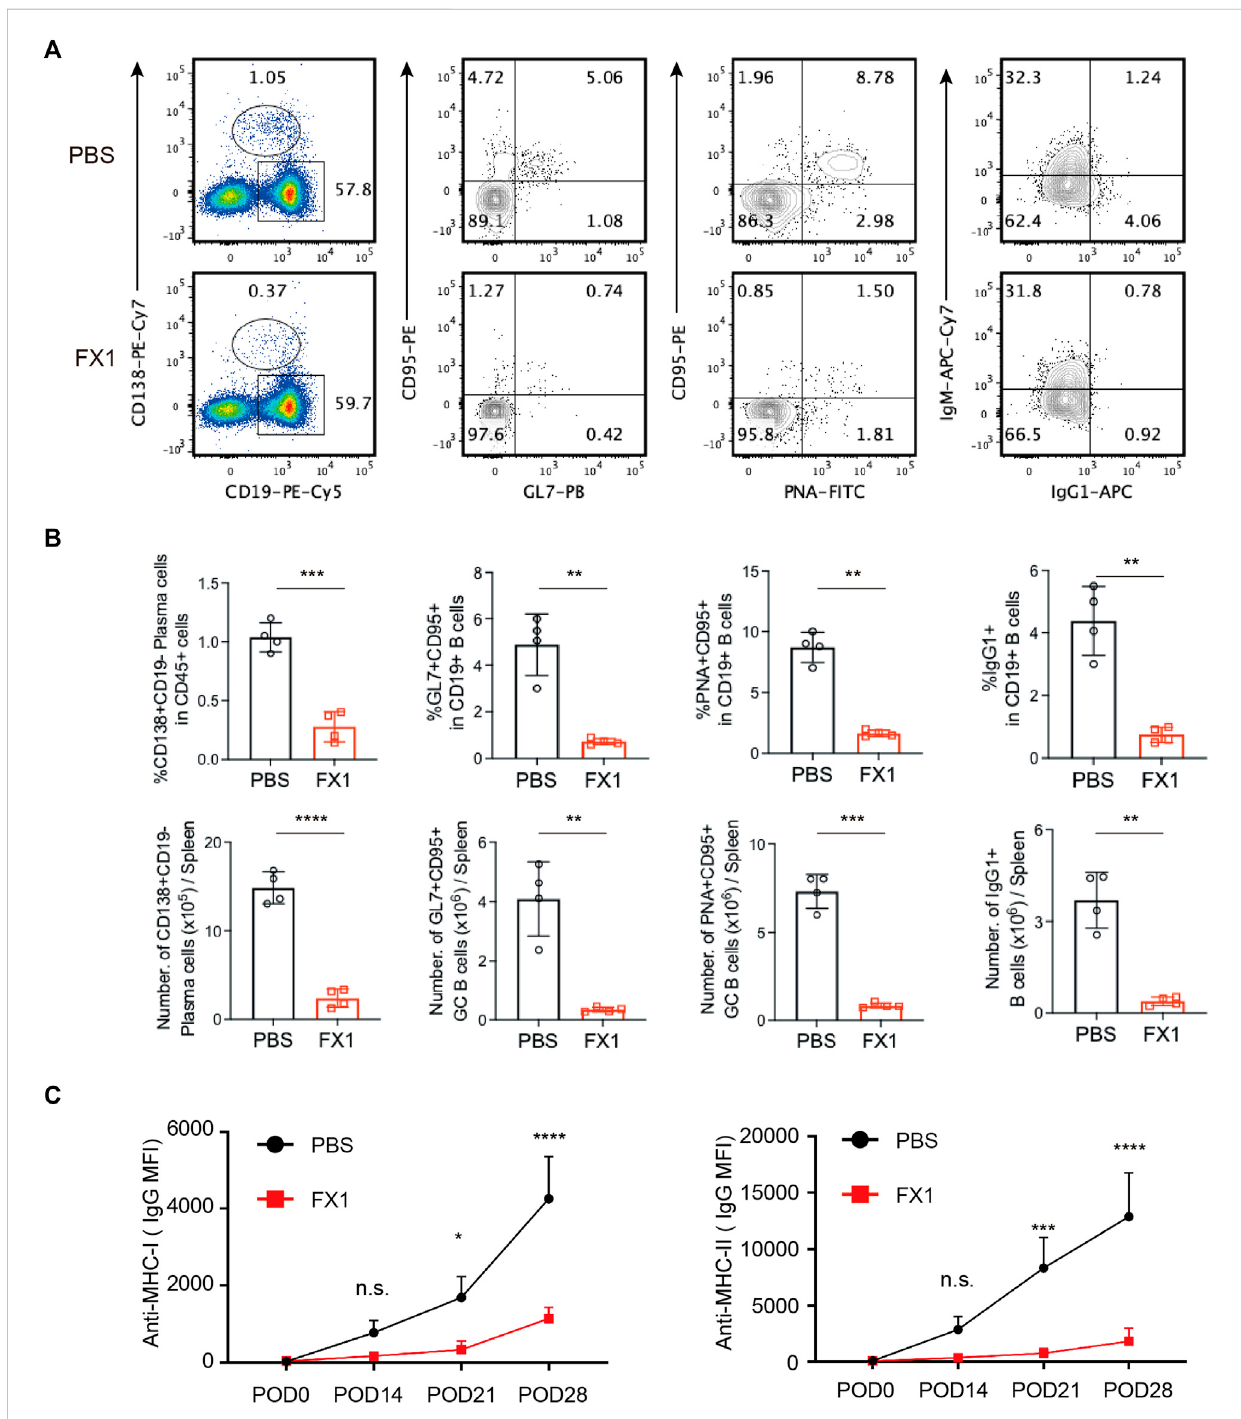
FIGURE 6 FX1 inhibits humoral response during chronic cardiac transplant rejection in mice (A) . Spleens were obtained from the recipient mice on postoperative day 28, ground into single-cell suspensions for FCM detection, and stained for the ratios of CD19 − CD138+ plasma cells, GL7+CD95+Bcells,PNA+CD95+Bcells,andIgG1+CD19+Bcells (B) .Thebarcharts( n =4)illustratetheratiosandnumberofCD19 − CD138+plasmacells, GL7+CD95 + GC B cells, PNA+CD95 + GC B cells, and IgG1+CD19+B cells in both groups (C) . The sera of the mice in both groups were collected 0, 14, 21, and 28 days postoperatively to measure the concentrations of anti-MHC-I and anti-MHC-II